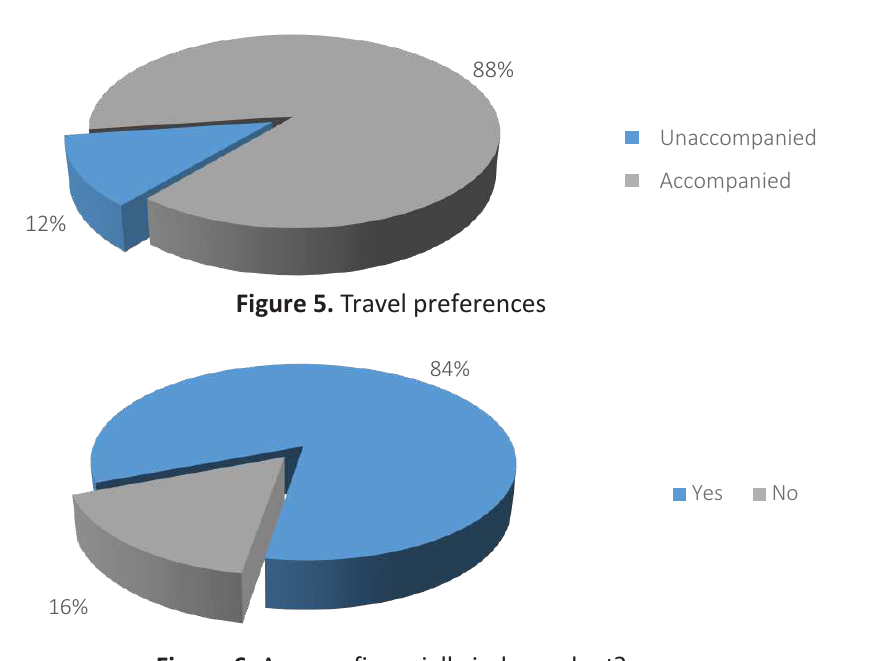
Figure 4. Means of information about the site